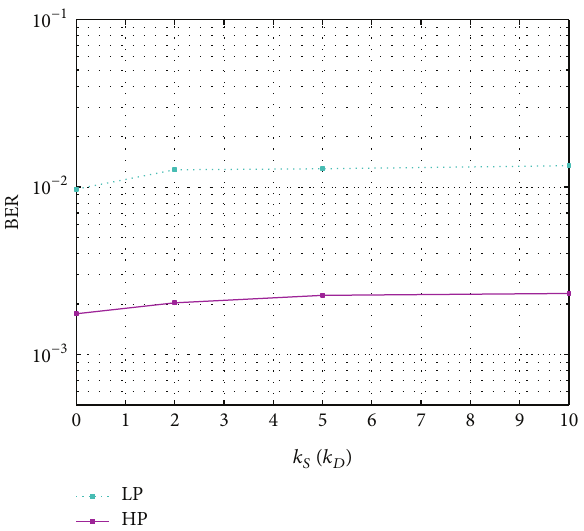
Figure 8: BER for increasing values of the degree of scattering within cylinders 1 and 2.